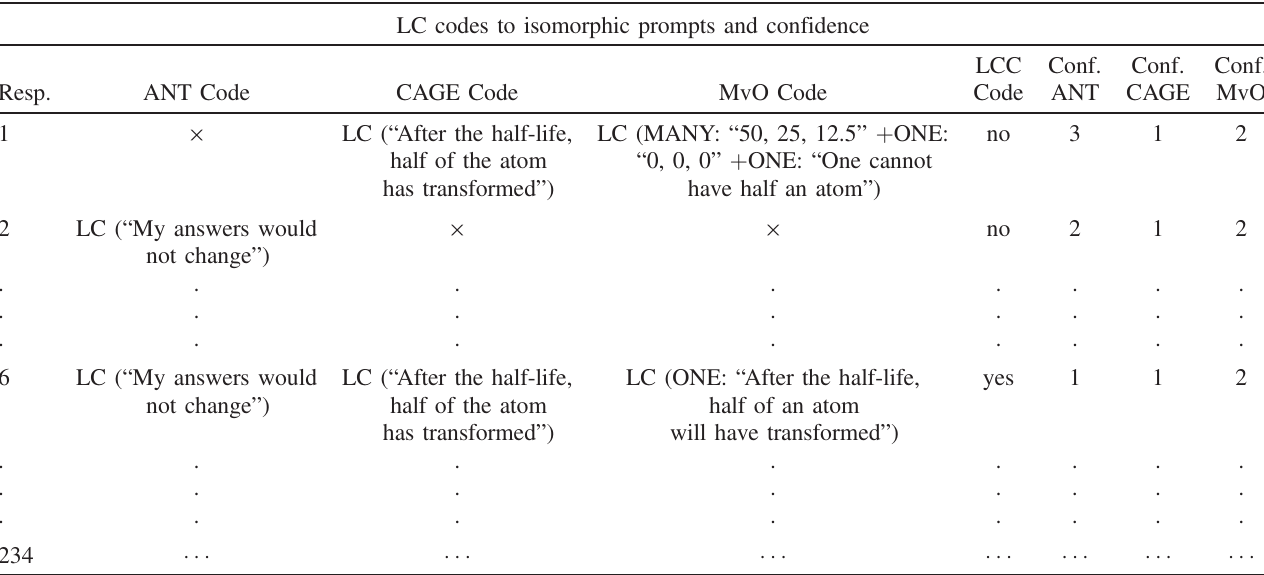
TABLE II. Three example survey responses (from N ¼ 234 ) for considering correlation between confidence and consistency in LC codes a . “ Resp. ” is an abbreviation for “ Respondent ” and “ Conf. ” is an abbreviation for “ Confidence ” . LC codes to isomorphic prompts and confidence